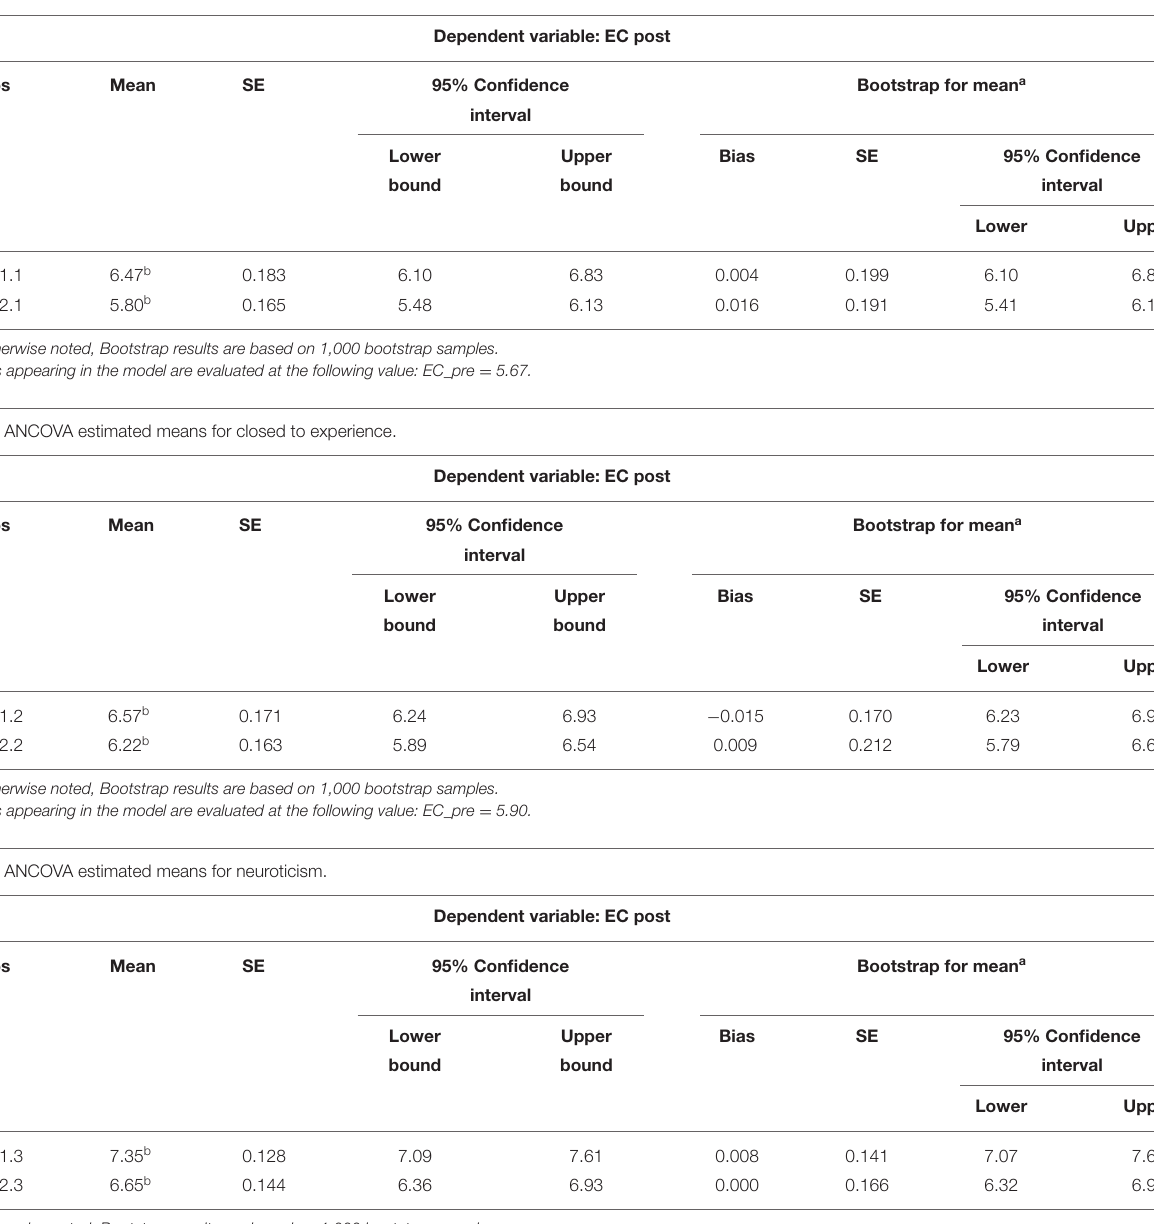
TABLE 7 | ANCOVA estimated means for introversion.